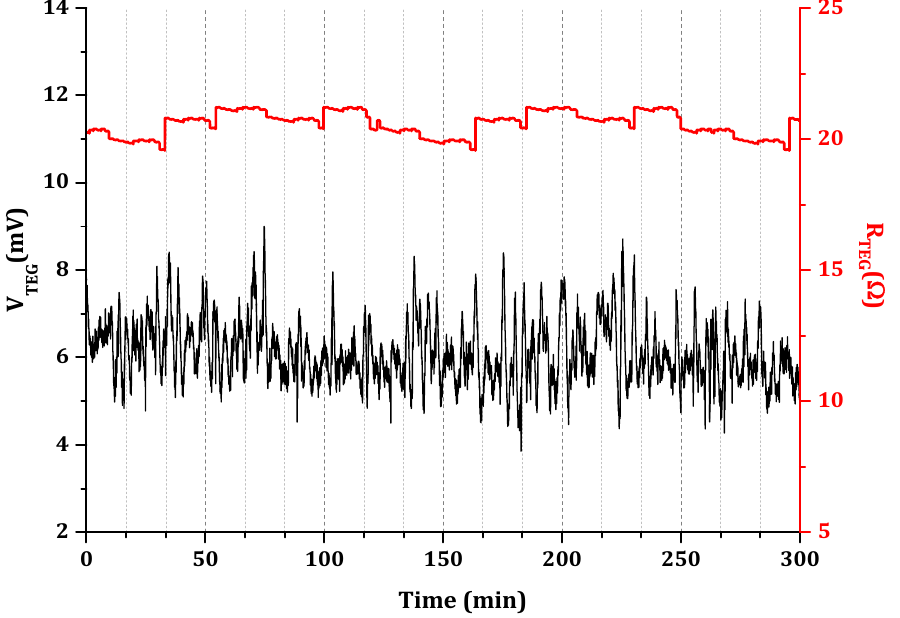
Figure 4. Stability verification of 28-day one-part SWCNT-alkali-activated nanocomposites at Δ T = 60 K.